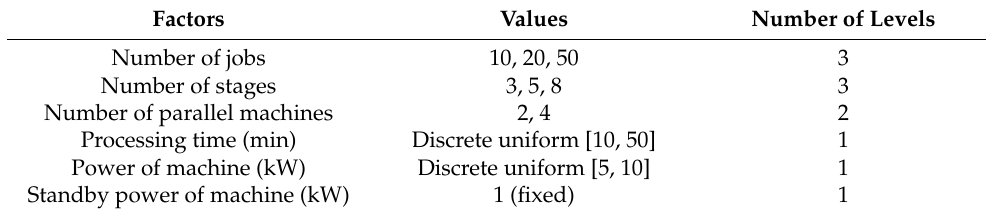
Table 5. Summary of test